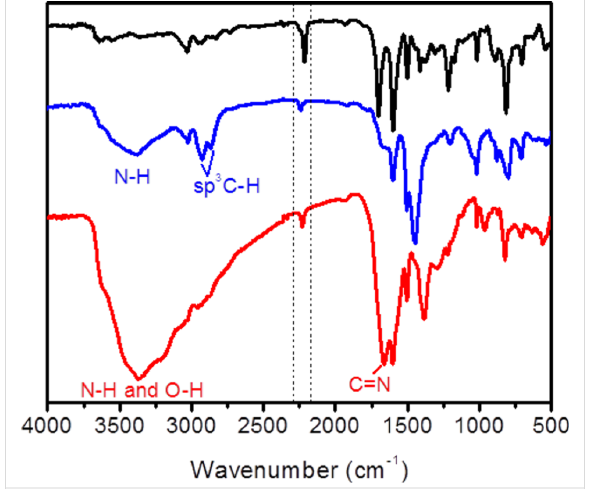
Figure 1: FTIR spectra of COP-156 (black), COP-156-amine (blue) and COP-156-amidoxime (red). The dotted lines highlight the charac- teristic stretching for the nitrile functionality (2215 cm − 1 ), which loses intensity by the post-modification